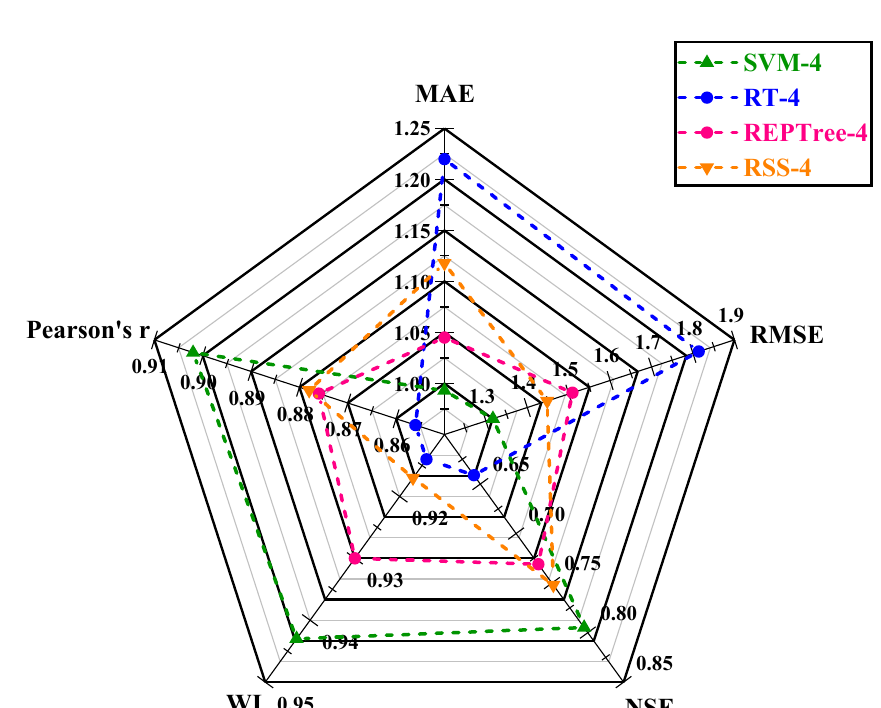
Figure 13. Radar charts display the best performance indicators of SVM-4, RT-4, REPTree-4, and RSS-4 models during testing at the Ludhana station.